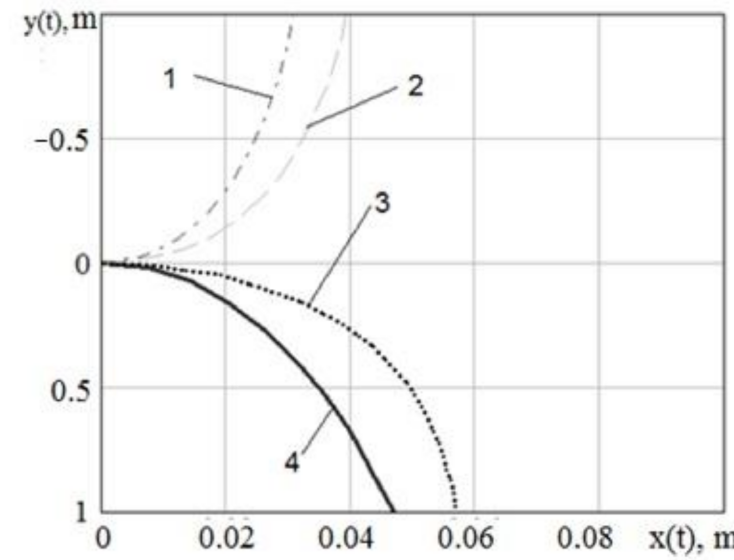
Figure 5. The trajectory of motion of the particles of the components of the grain mixture in the vertical pneumatic separation duct: 1— ρ p =150 kg · m − 3 ; 2— ρ p =200 kg · m − 3 ; 3— ρ p =600 kg · m − 3 ; 4— ρ p =700 kg · m − 3 (U = 7 m · s − 1 ; d p = 0.0015 m; θ = 40 ◦ , V = 6 m · s − 1